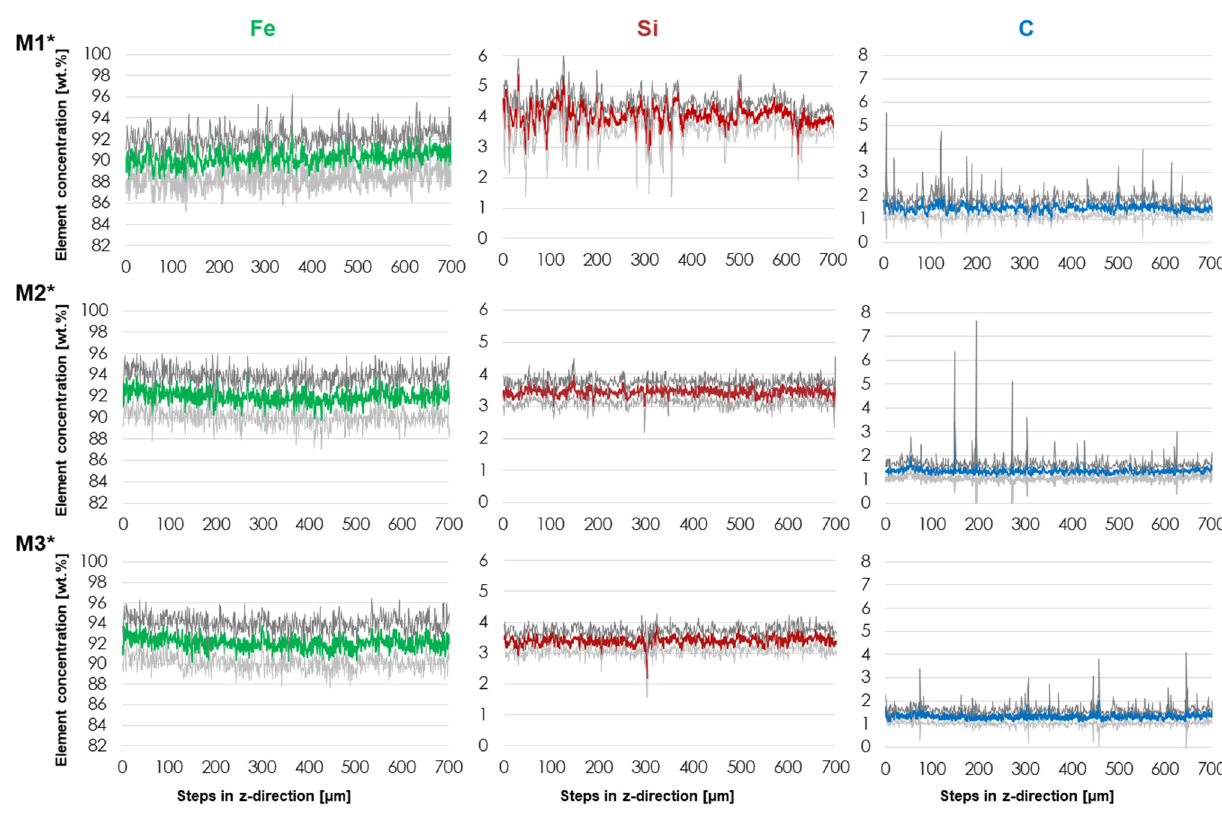
Figure 9. Microprobe results for M1*, M2* and M3* (green: mean Fe, red: mean Si, blue: mean C, dark grey: mean plus standard deviation, light grey: mean minus standard deviation).